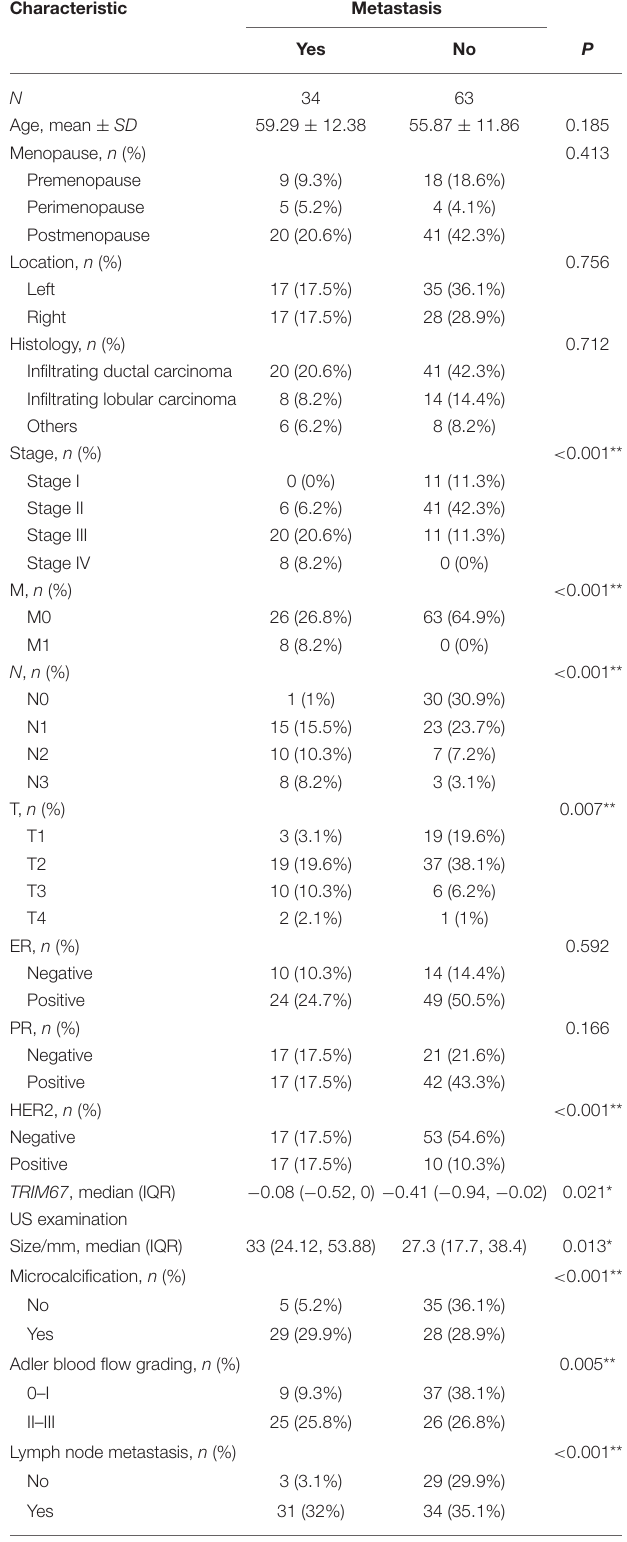
TABLE 1 | Baseline characteristics of patients in the clinical